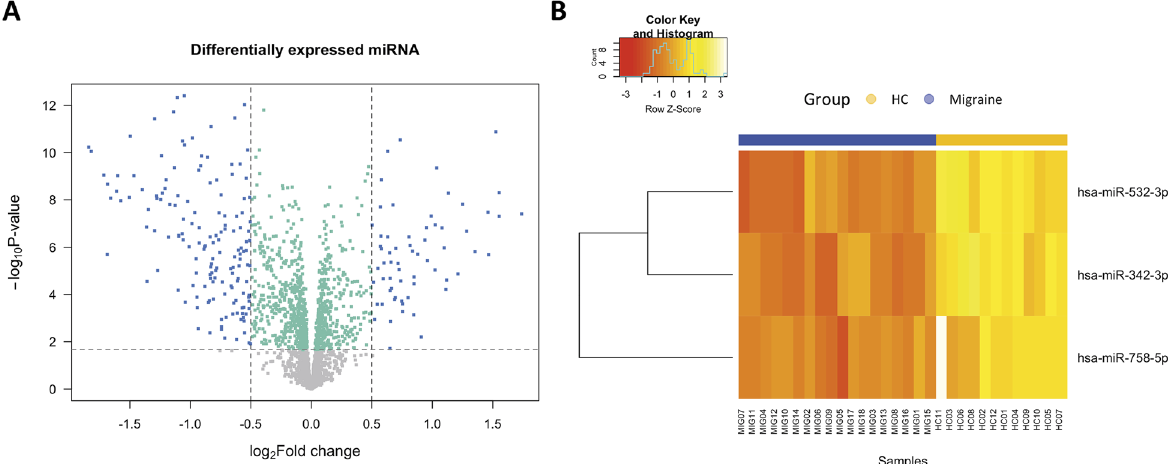
Fig. 3 Volcano plot ( A ) and heatmap ( B ) of differentially expressed miRNA between healthy controls and patients with migraine. Scattered points from the volcano plot ( A ) represent miRNAs: the x‑axis is the log twofold‑change for the ratio healthy controls vs patients with migraine, whereas the y‑axis is the log 10 P ‑value. Colored dots (blue and green) are differentially miRNA statistically significantly over‑ (right) and under‑expressed (left) in patients compared to controls. Blue dots are differentially expressed miRNA with a log twofold‑change > 0.50. A heatmap ( B ) of the 3‑miRNA signature selected from the classification algorithm (RF). Columns represent individual arrays, while rows represent specific DE miRNA. The Z‑score depicts a measure of distance, in standard deviations, away from the mean. The relative value for each miRNA is depicted by color intensity, with yellow indicating over‑expression and red indicating under‑expression. HC: healthy controls; MIG: patients with